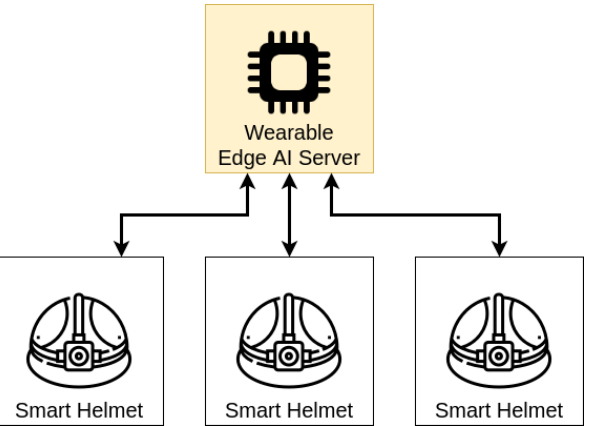
Figure 4. Proposed general architecture. The smart helmets use the wearable edge AI server to provide machine learning